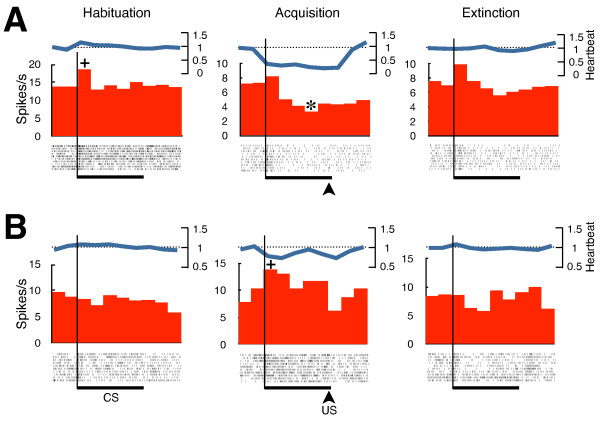
Peristimulus time histograms of simple spikes and heartbeat frequencies in the habituation, acquisition (last ten trials), and extinction sessions. Average responses of ten consecutive trials in each session are shown. Relative heartbeat frequencies in relation to average heartbeat frequency in the 2 s before the CS are shown. Rastergrams of simple-spike timings are also shown below the frequency plots. Horizontal bars indicate periods of CS presentations. Arrowheads indicate the timing of the US presentations. + and * denote significantly higher and lower frequencies relative to the highest or lowest bin in the 2 s before the CS, respectively (Wilcoxon signed rank test, p < 0.05). CS: conditioned stimulus; US: unconditioned stimulus; s: seconds.